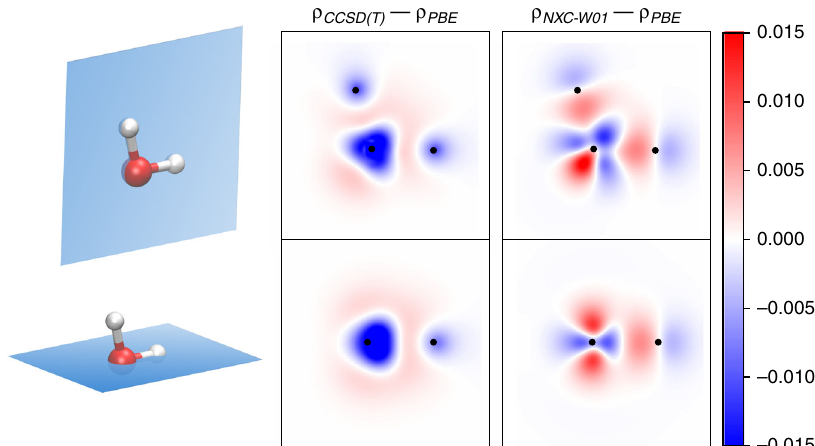
Fig. 7 Electron density of water. Comparison of the difference in electron density between CCSD(T) and PBE and NXC-W01 and PBE for a water molecule in its experimental equilibrium geometry. Two dimensional cuts either correspond to high-symmetry planes or planes containing a signi fi cant number of atoms and are indicated by blue surfaces in the molecule depictions adjacent to the density plots. Black dots inside the density plots indicate the positions of in-plane atoms. Atoms are color-coded with red corresponding to oxygen and white to hydrogen. Color scale is in units of e × Bohr − 3